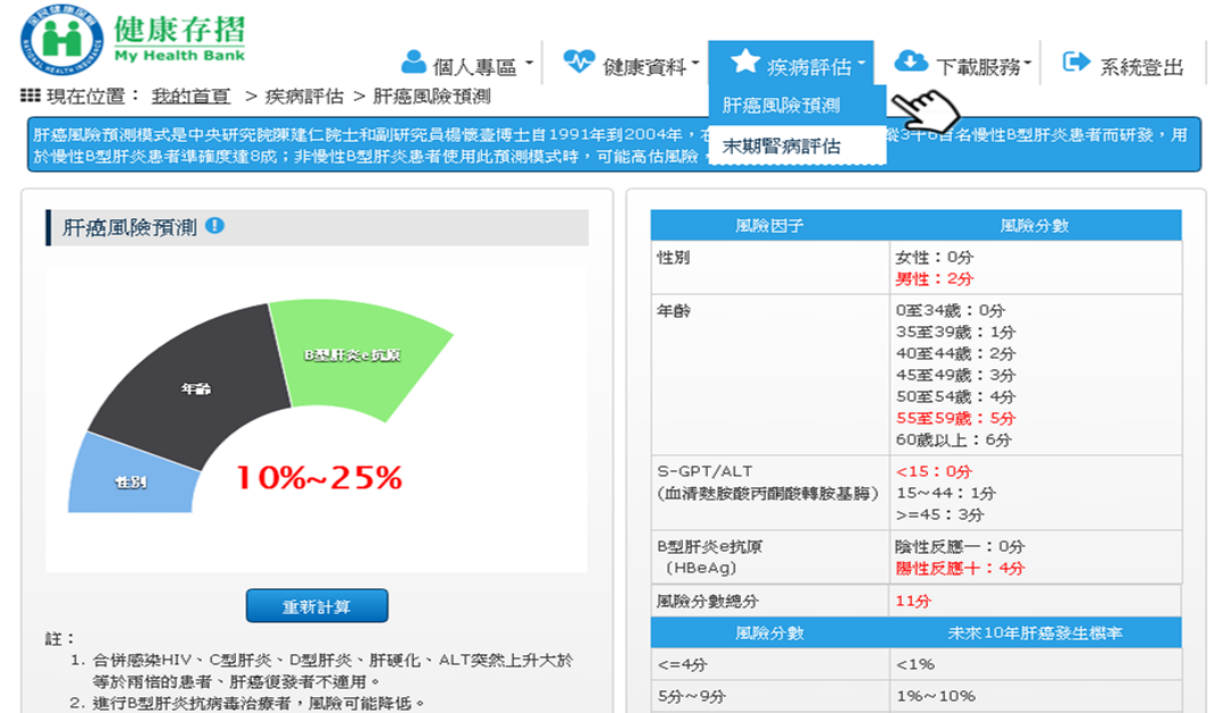
Figure 2. Disease management services (screenshot from My Health Bank): After the user enters their basic information, the system predict the risk of major diseases (eg, hepatic cancer and end-stage renal disease) and then provide links to external websites for further health information queries.